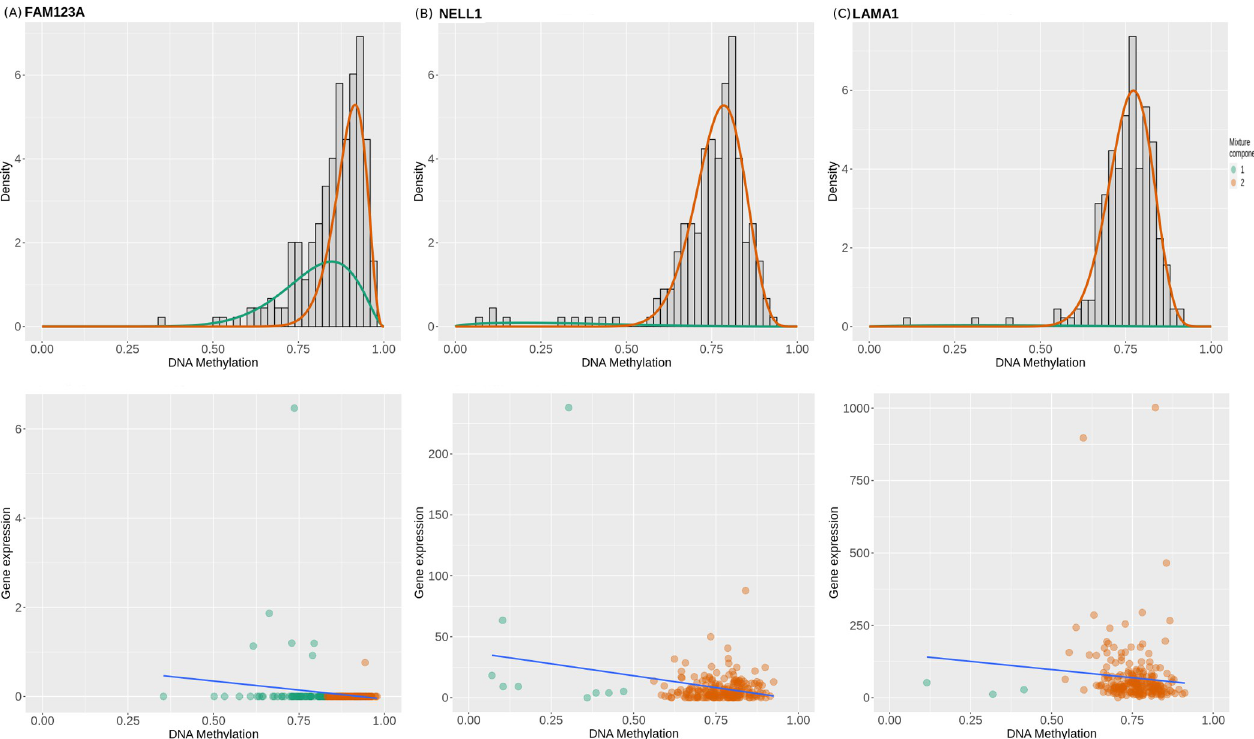
Fig 6. Mixture models and Correlation plots for (A) FAM123A, (B) LAMA1 and (C) NELL1. The x-axis indicates the level of methylation (in terms of β values); y-axis, the frequency. Mixture component curves represent density fits of the histogram. A negative correlation between methylation and expression is evident, indicating that methylation acts to repress gene transcription, though the strength of the inverse correlation varies from gene to gene. olour indicates the mixture model fit.